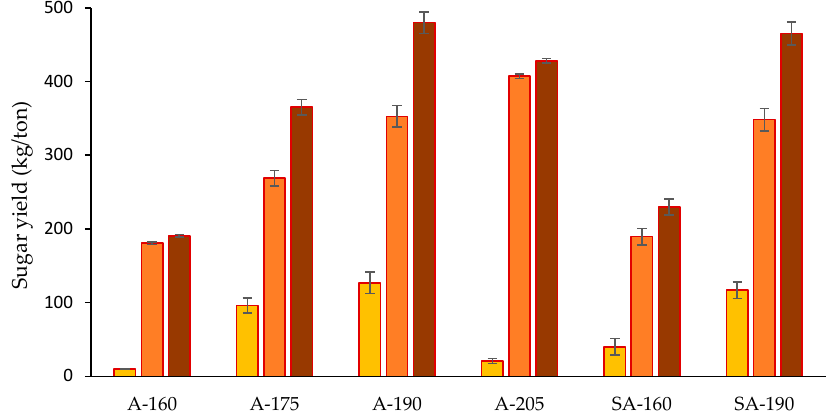
Figure 5. Yield of xylose (yellow bars), glucose (orange bars), and total sugar (brown bars) after pretreatment and enzymatic hydrolysis. Values are given in kg per ton raw wheat straw. Same codification of experimental conditions as in Table 1.